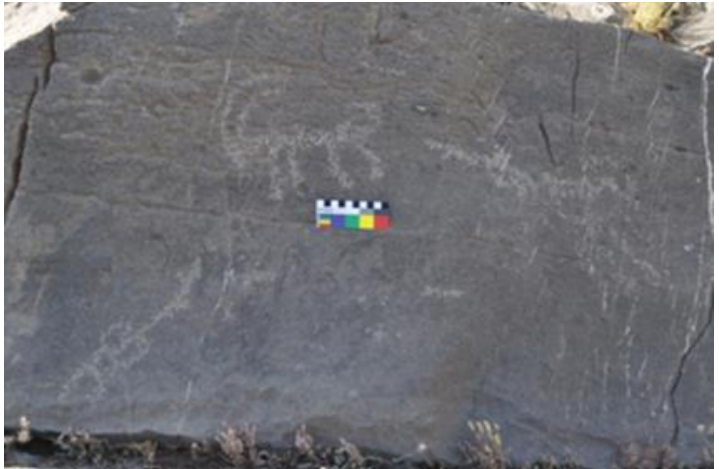
Figure 10. Ghārā-Tepe I, panel 7, hunting